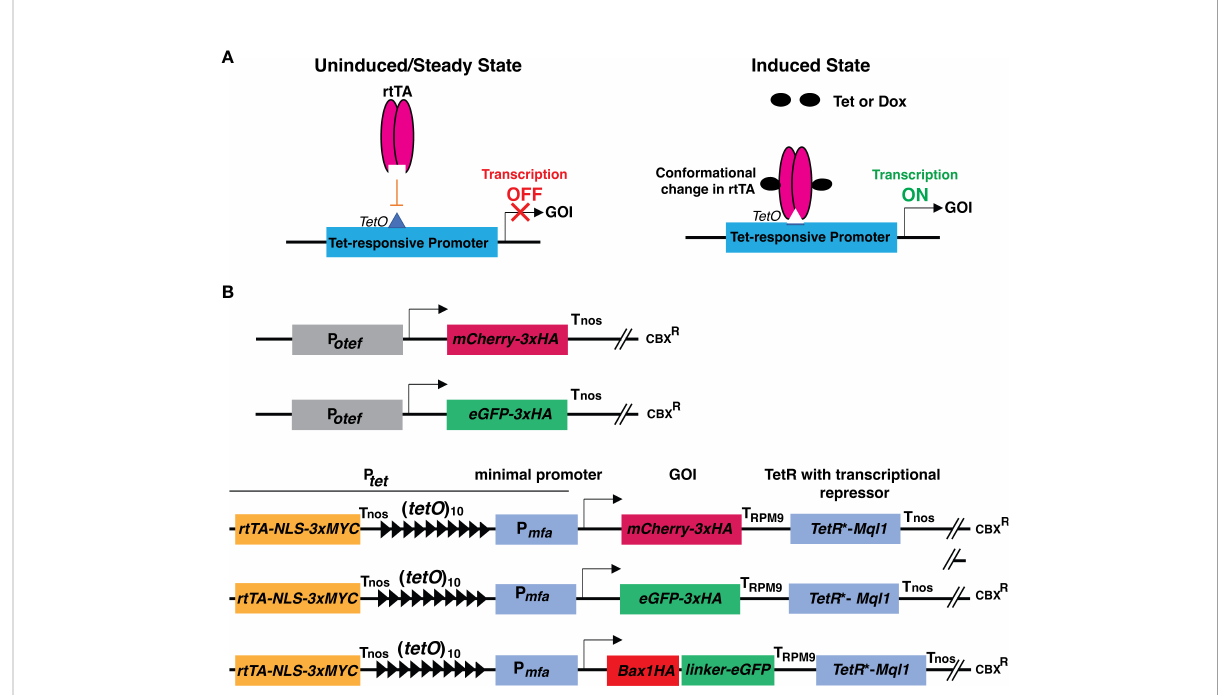
FIGURE 1 Schematic representation of principle of TetON system and cloning strategies used in this study. (A) Schematic representation showing the operational principle of the TetON system in uninduced and induced conditions. (B) Schematic representations of constructs with P otef and P tet used in this study. Arrow indicates the transcriptional start